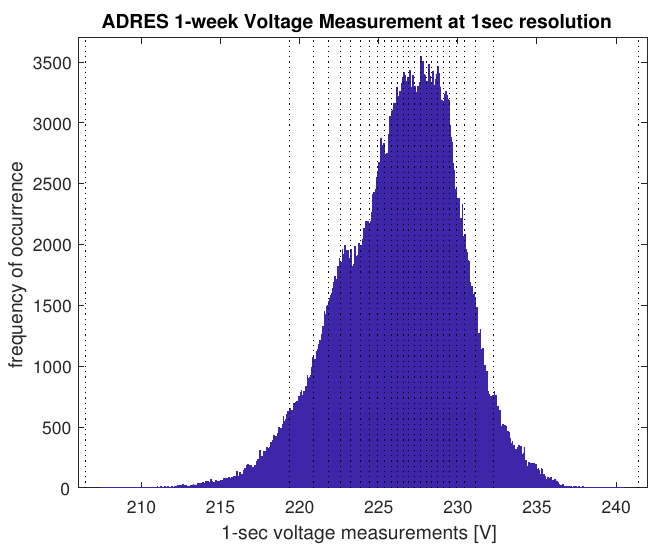
Figure 1. Histogram of one voltage measurements (including visualization of boundaries for dis- cretization used later in Section